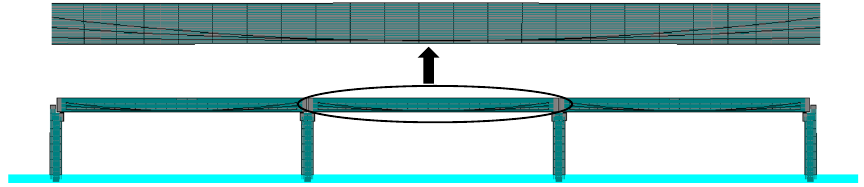
Fig. 7 IAEM model of the analyzed bridge